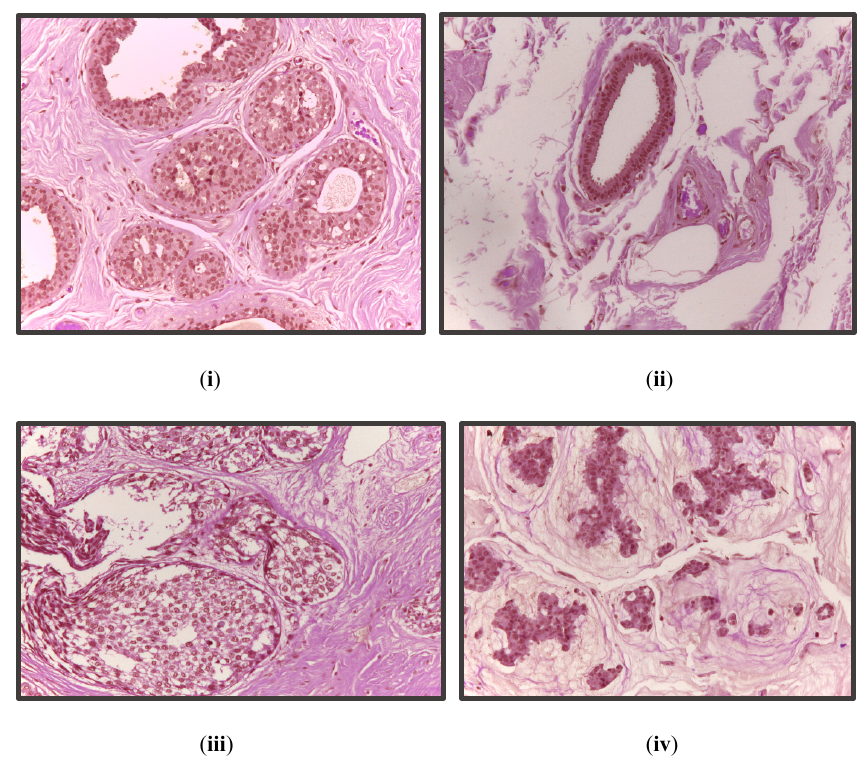
Figure 2. From top left in clockwise manner: ( i ) benign, ( ii ) normal, ( iii ) invasive, and ( iv ) in situ.